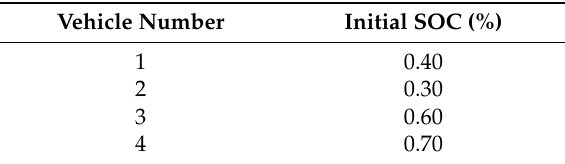
Table 1. Initial State of Charge (SOC) of the electric vehicles.